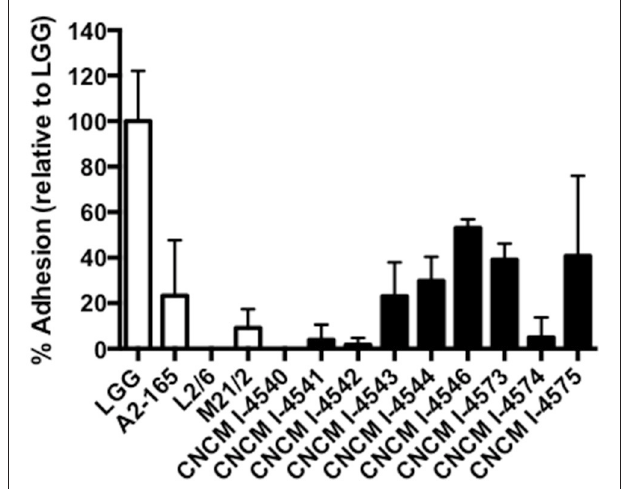
FIGURE 7 | Adhesion to mucin of F. prausnitzii strains. Experiments have been done in triplicate. The adhesion values have been normalized using Lactobacillus rhamnosus GG (LGG) a positive control know by their good adhesion properties to mucin (50). Results are presented by the mean and the standard